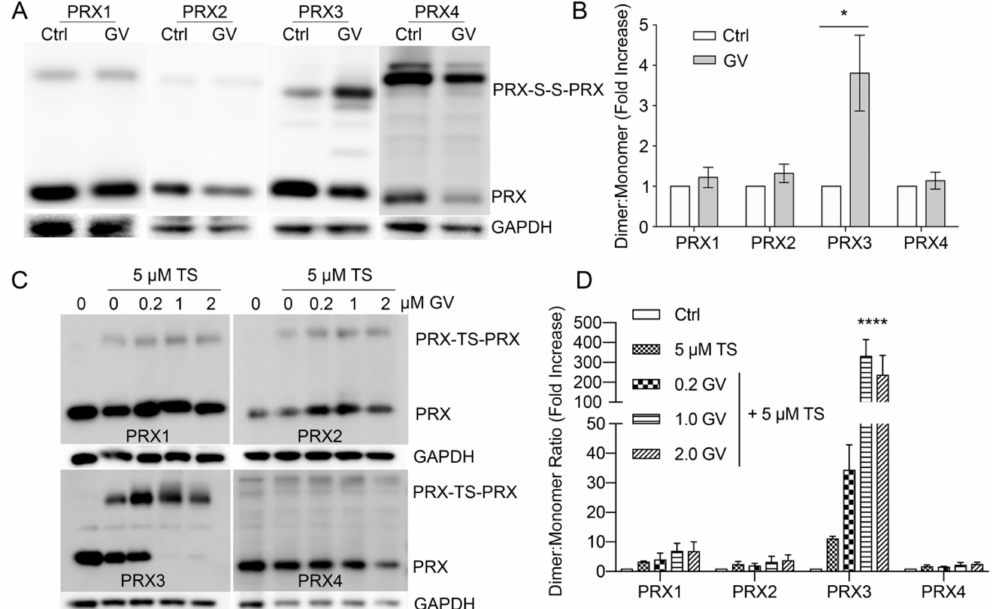
Figure 6. Specificity for Gentian violet (GV) to potentiate TS crosslinking of mitochondrial PRX3. ( A ) Western blots of PRXs 1–4 from MM tumor cells incubated with 1 µ M GV for 24 h. Lysates were run on non-reducing SDS-PAGE gels. PRX-S-S-PRX represents the native intermolecular disulfide; the band above this indicated region in PRX4 is a non-specific band. ( B ) Quantification of PRXs 1–4 disulfide formation induced by GV under non-reducing conditions ( n = 3). ( C ) Western blots of PRXs 1–4 from MM tumor cells incubated with 5 µ M TS or 5 µ M TS + indicated concentration of GV for 24 h. Lysates were run on reducing SDS-PAGE gels. ( D ) Quantification of PRXs 1–4 covalent crosslink by TS or TS + GV under reducing conditions. (* p < 0.05; **** p <